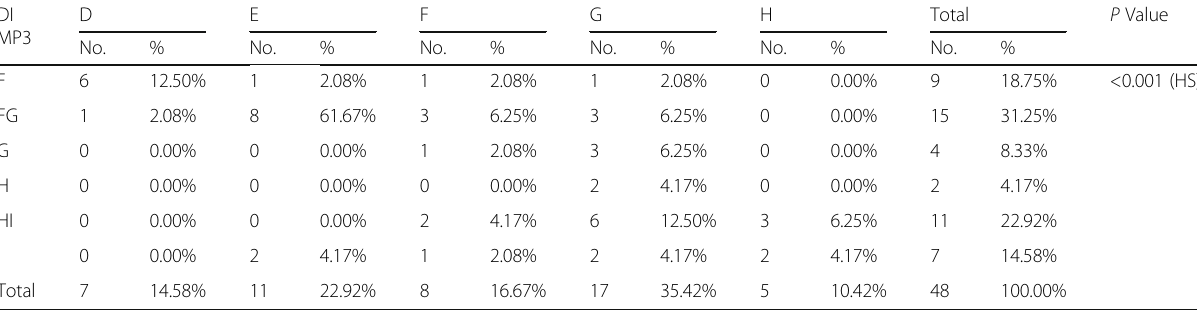
Table 3 Stages of modified MP3 compared with the stages of DI (male)